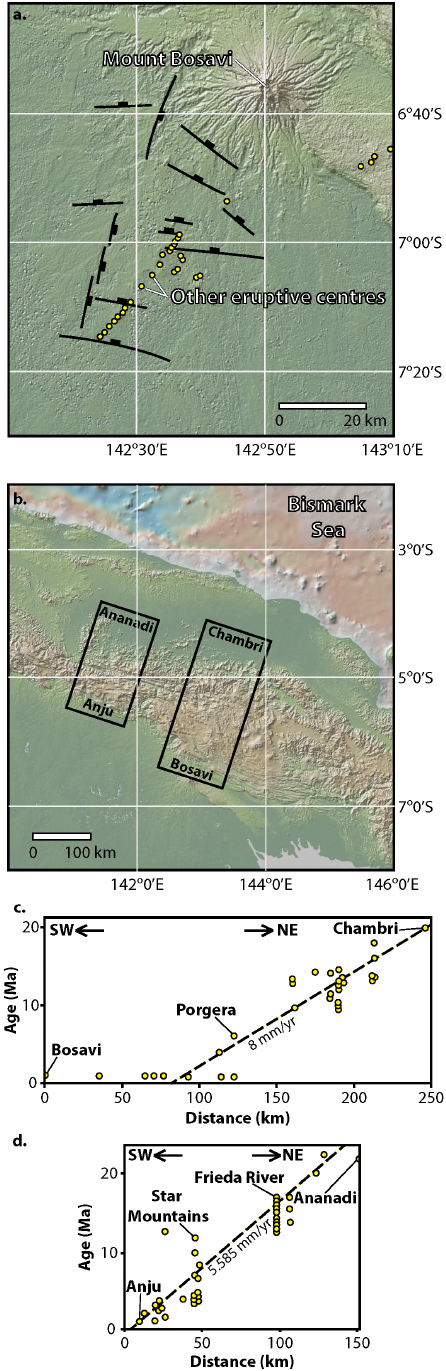
Fig. 2. A chain of volcanics near Bosavi was identified by Davies (1990, 1991) who showed that magmatism in this region progressed from north to south across Papua New Guinea. This pattern is ob- served (a) locally where active volcanism occurs at Mount Bosavi and in smaller eruptive centres to the south, and (b) regionally. Davies (1990) drew to cross sections from Ananadi to Anju and Chambri to Bosavi to show that (c–d) the volcanic front migrated at a rate of 6–8mmyr − 1 . Figure was modified from Davies (1990). The basemap in (a) and (b) is from the Global Multi-Resolution Topography (GMRT) data set (Ryan et al.,